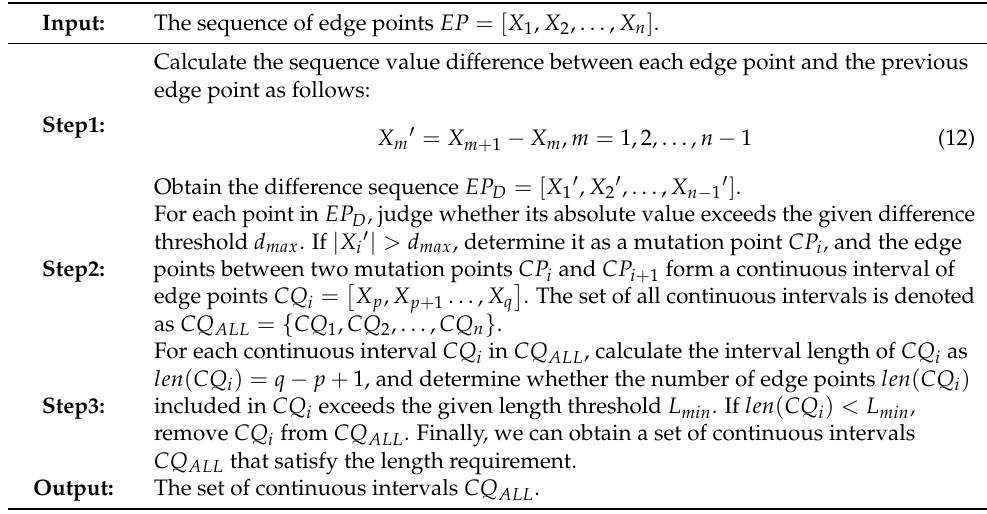
Table 3. Steps of the Continuity